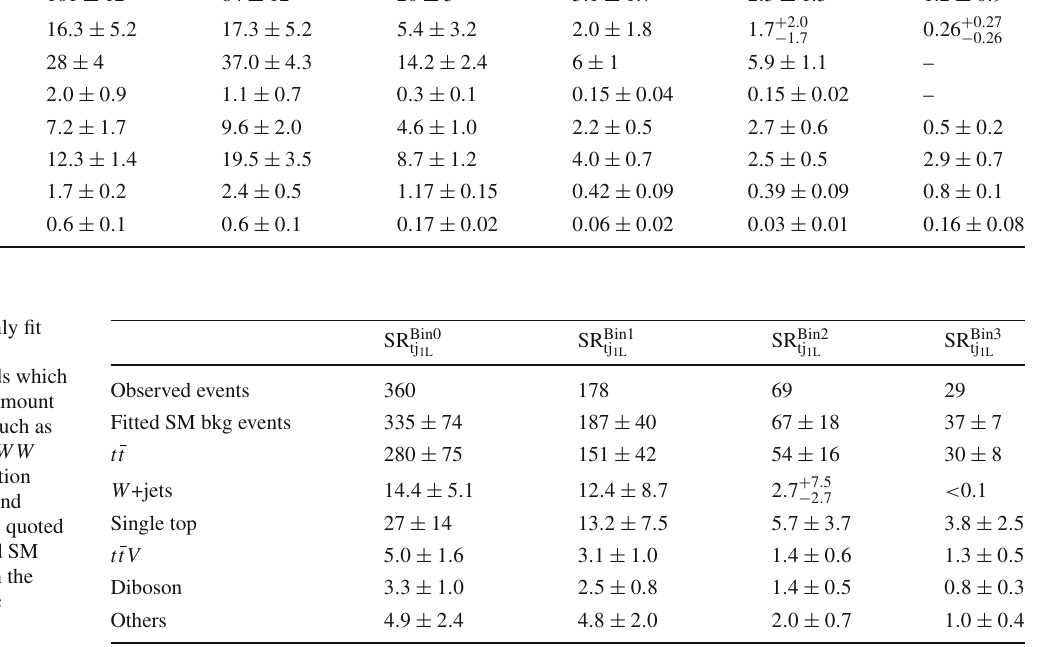
Table 6 Background-only fit results for the tW 1L and tW 2L signal regions. The backgrounds which contribute only a small amount (rare processes such as triboson, t ¯ t t ¯ t , t ¯ t WW and Higgs boson production